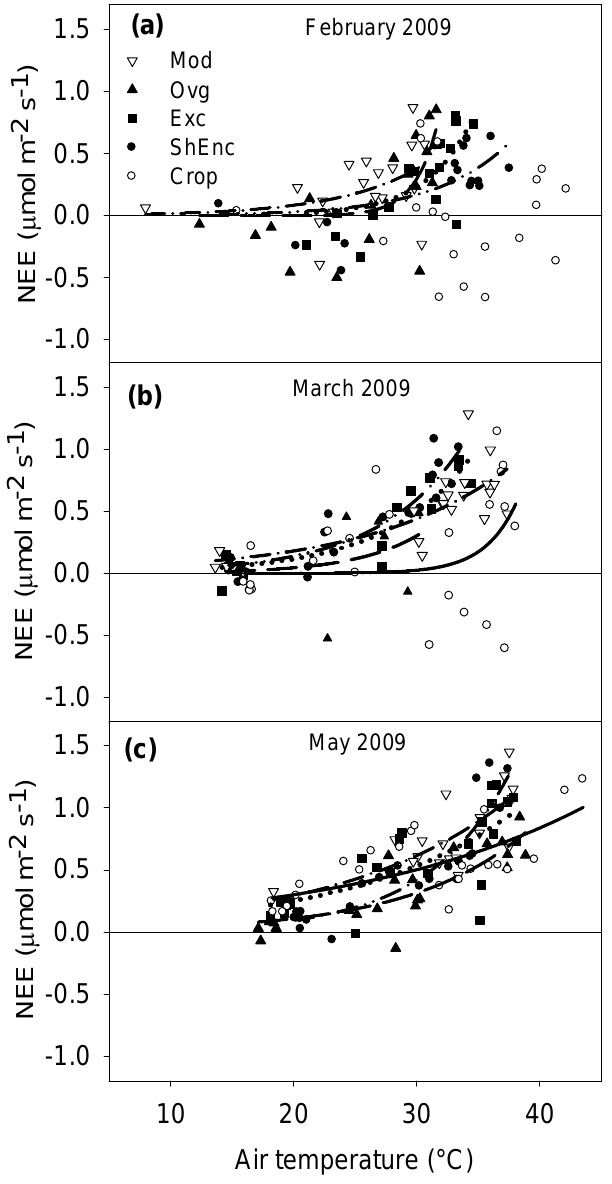
Fig. 6. Exponential relationships between daytime NEE and T a for February (a) , March (b) and May (c) in five contrasting land use types in the shortgrass steppe in central Mexico. All regressions were statistically significant at P < 0.05, with exception of the oat crop site in March. Also for March, the Ovg site curve is missing because there were not enough data. Daytime NEE resulted in a positive flux ( R e ) in this period because vegetation was senescent and LAI was ∼ 0; therefore, PPFD did not exerted control on